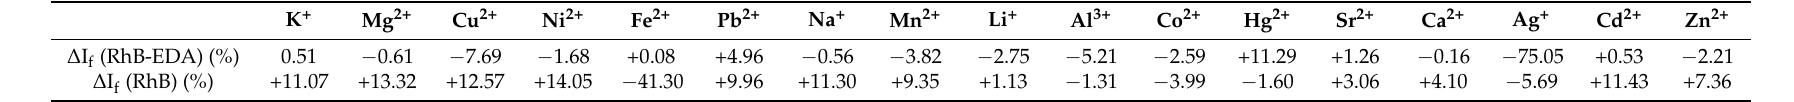
Table 1. Fluorescence signal change of RhB and RhB-EDA to various metals ions at pH